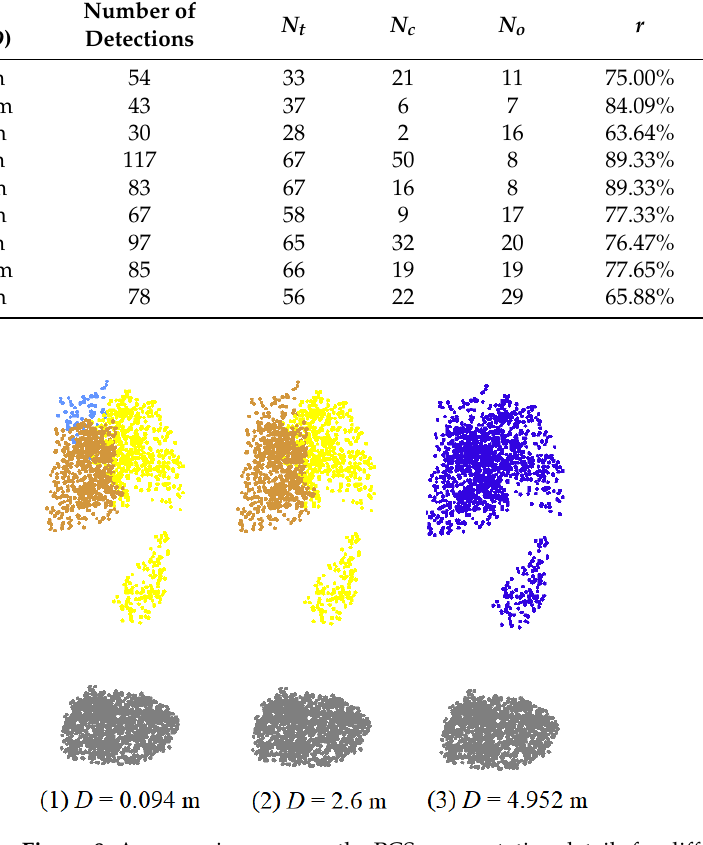
Figure 8. A comparison among the PCS segmentation details for different values of D .